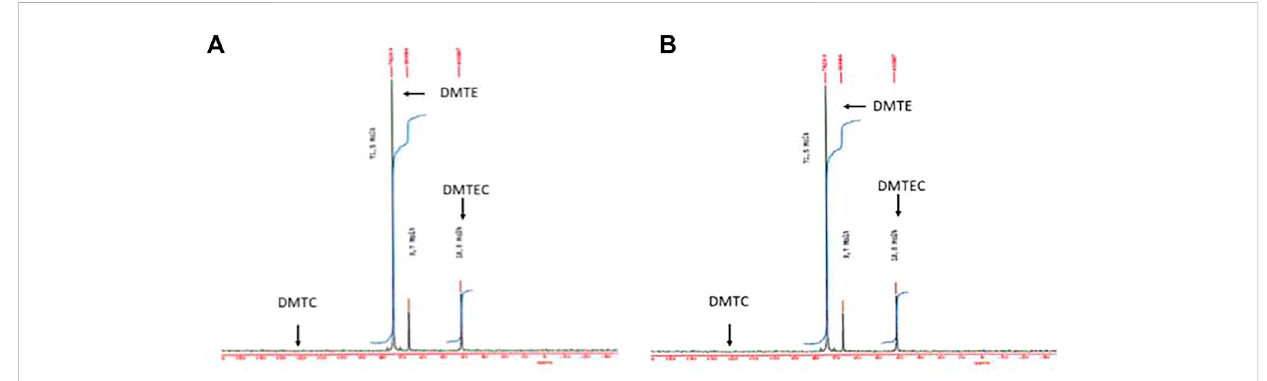
FIGURE 2 119 Sn-NMR spectra of the material isolated from the simulated gastric hydrolysis are presented. (A) DMTE after 30 s in gastric media at pH 1.2 and 37 ° C; (B) DMTE after 4 h in gastric media at pH 1.2 and 37 °